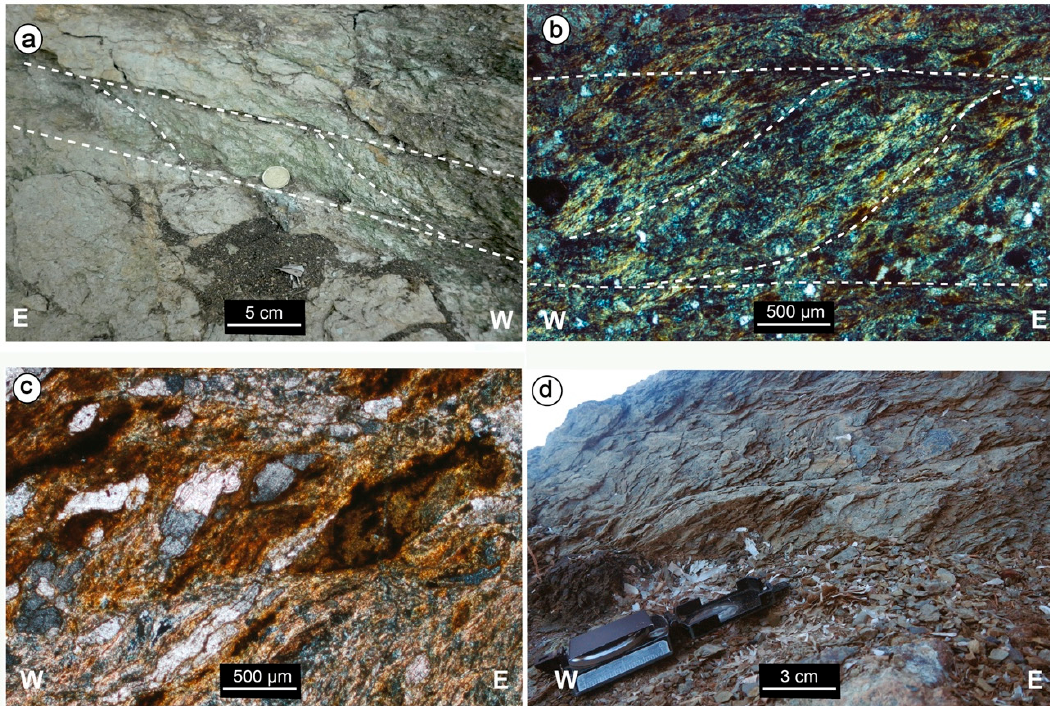
Figure 5. Protomylonitic domains in the quartzo-feldspathic rocks ( a – c ) and in the ( d ) calcilutite of oceanic pertinence. ( a ) S/C structures with a top-to-the-east shear sense and related line drawing; ( b ) microscale S/C structures by micas and Fe-oxides and related line drawing; ( c ) crossed polars micrograph showing S surface underlined by magnesite ribbons, micas and Fe-oxides; ( d ); top-to-the-east S/C structures in the calcilutite.